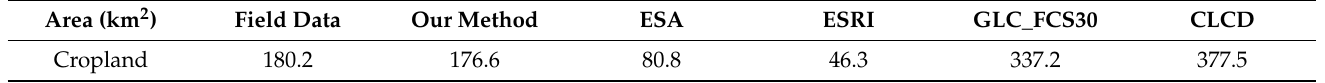
Table 4. Cropland area statistics of different